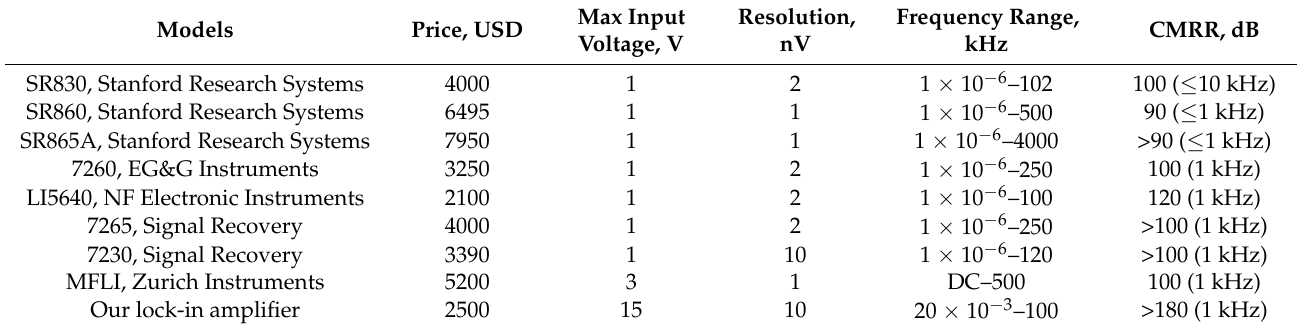
Table 7. Comparison of commercially-available lock-in amplifiers and our lock-in